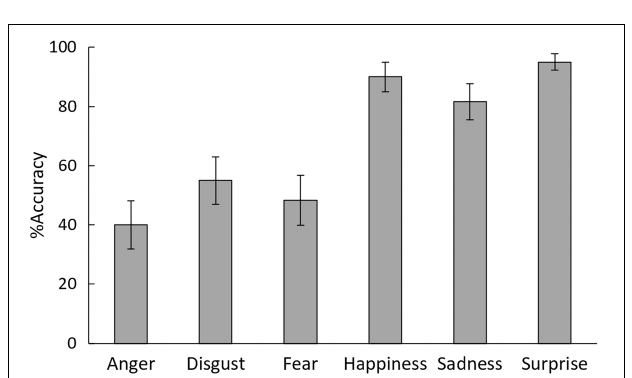
FIGURE 3 | Mean ( ± SE ) accuracy percentages for the recognition of six emotions in facial expressions in Study 2.